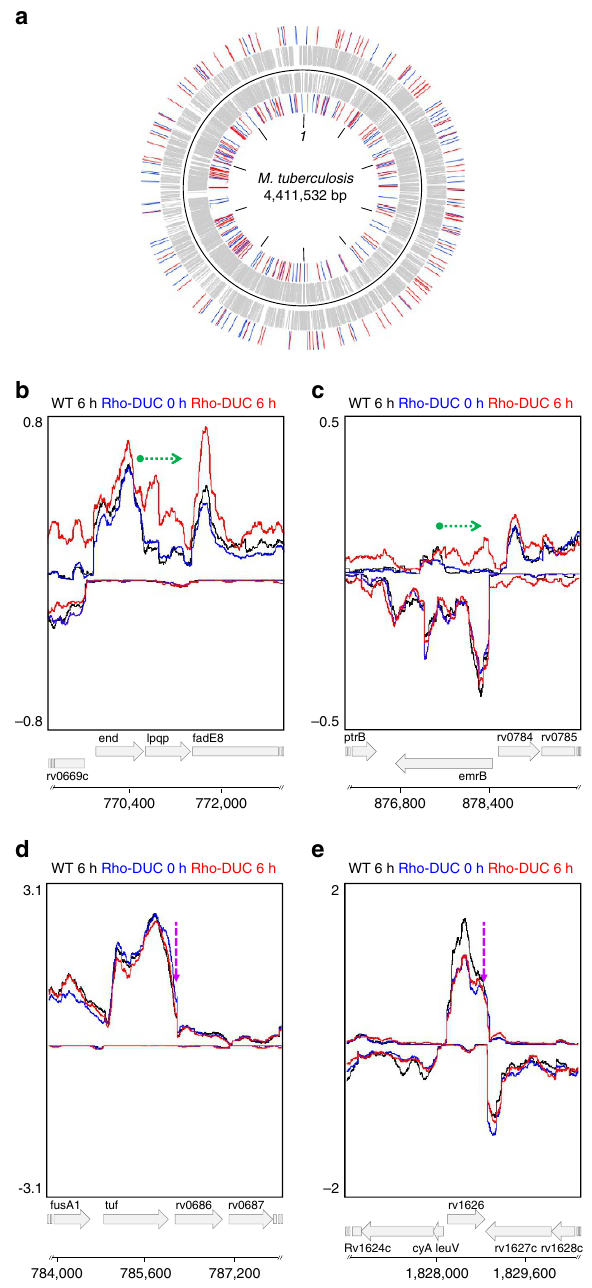
Figure 2 | RSRs affect sense and antisense transcription across the genome. ( a ) Distribution of the RSRs in the genome of M. tuberculosis . ( þ ) and ( (cid:2) ) strand features are depicted respectively on the outside and on the inside of the black solid line. Grey bars represent the genes, while the RSRs are indicated by blue (silencers) and red (transcripts terminators) bars. ( b , c ) Examples of RSRs visualized in the Artemis genome browser. ( d , e ) Examples of putative Rho-independent terminators visualized in the Artemis genome browser. The curves represent the average number of reads of replicates of the WTstrain at 6h of atc (black), and the Rho-DUC strain right before addition (0h, blue) or 6h after the addition of atc (red). The top half shows the traces obtained for the ( þ ) strand and the bottom half the traces of the ( (cid:2) ) strand. The green arrow indicates the RSR’s direction and length. The purple arrows indicate a putative Rho- independent terminator